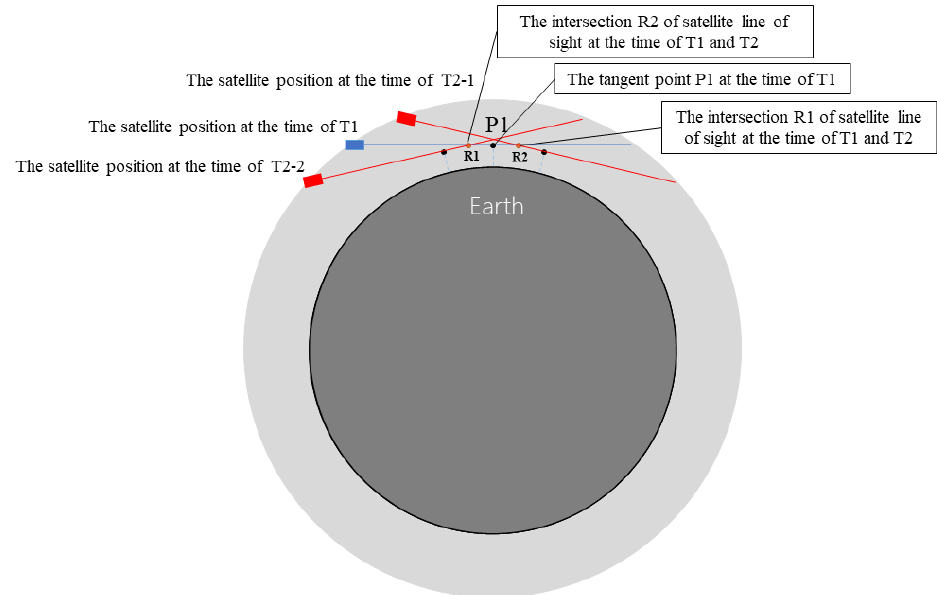
Figure 4. Limb geometry diagram for the three-dimensional limb mode at the time of T1 and T2. The blue line is the line of sight of SHS1. The red lines are the lines of sight of